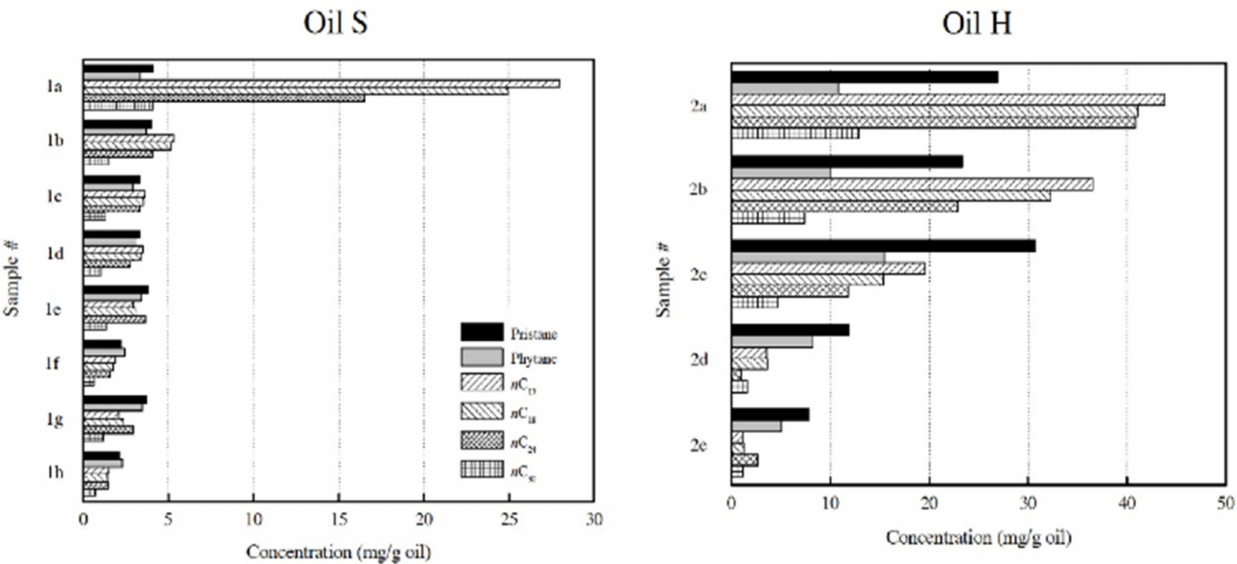
Figure 2. Concentrations of selected compounds (pristane, phytane, n -C 17 , n -C 18 , n -C 24 and n -C 30 alkanes) in the saturate fraction from oil samples analyzed in this study (Table S1). Calculations were performed based on areas in the m/z 85 mass chromatogram, with m/z 183 for squalane as an internal